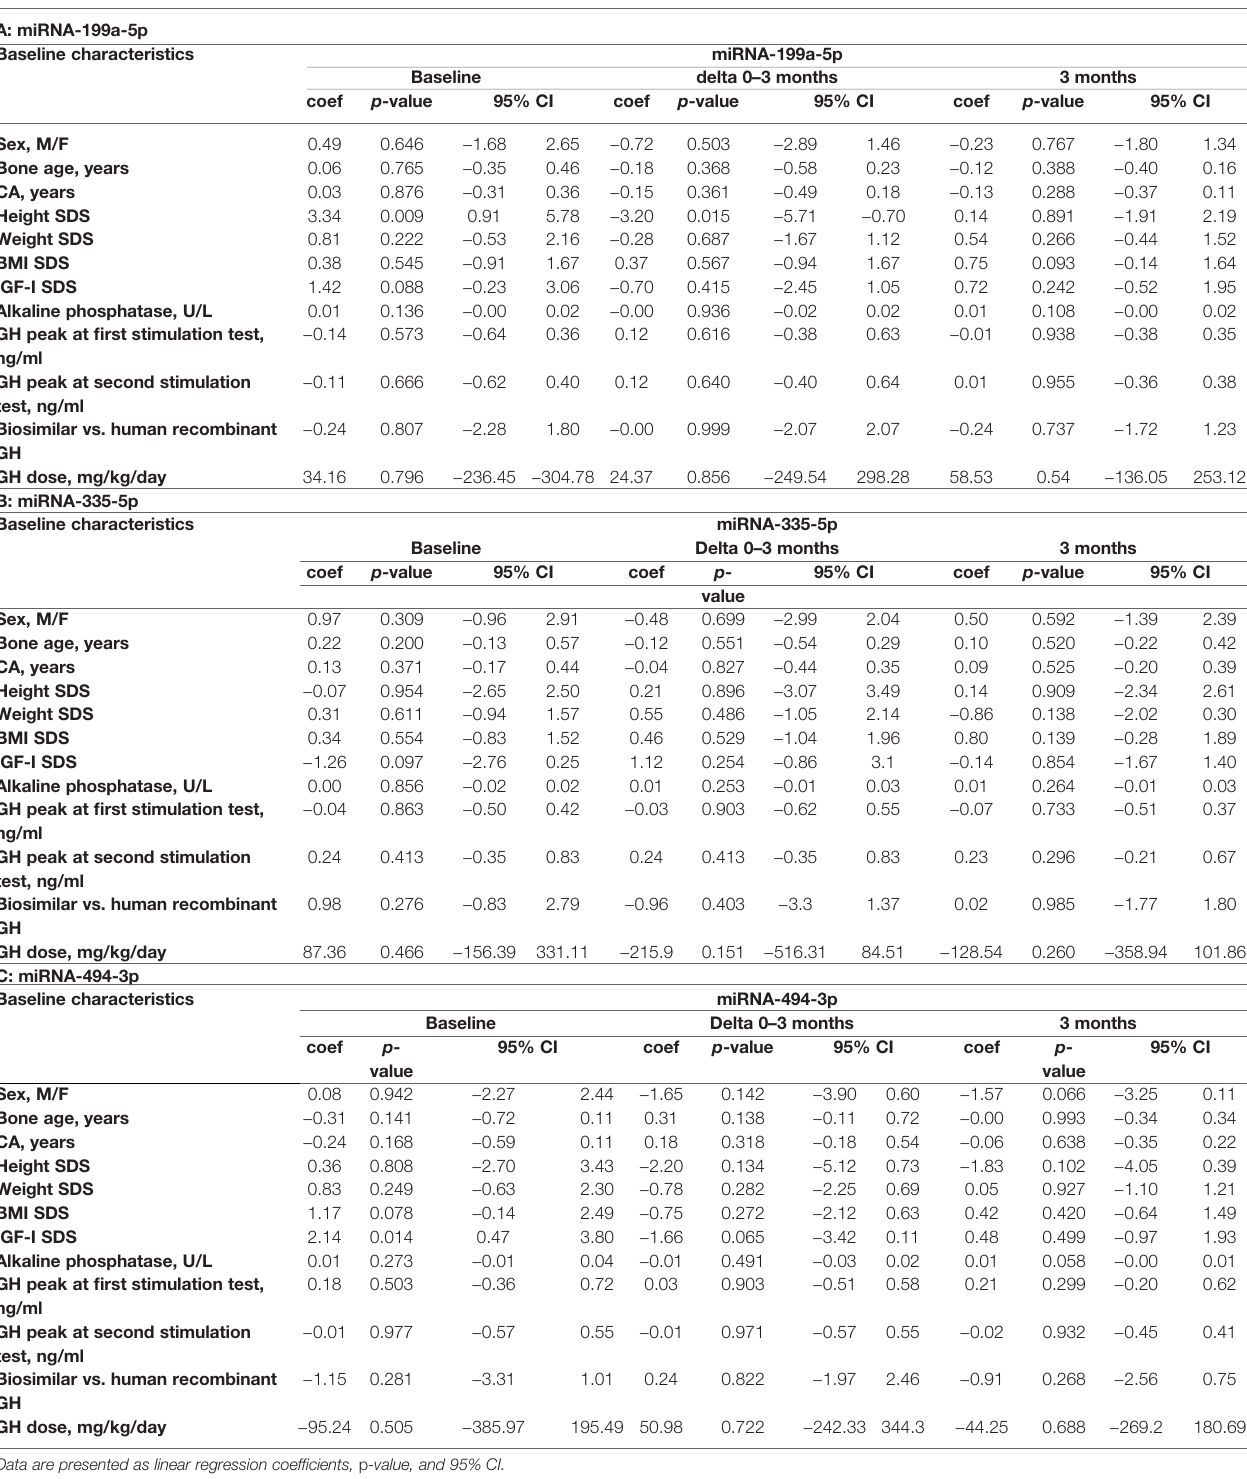
TABLE 3 | Associations between baseline characteristics, miR-199a-5p (A), miR-335-5p (B), and miR-494-3p (C) levels at baseline, their change between baseline and 3 months (delta), and after 3 months of